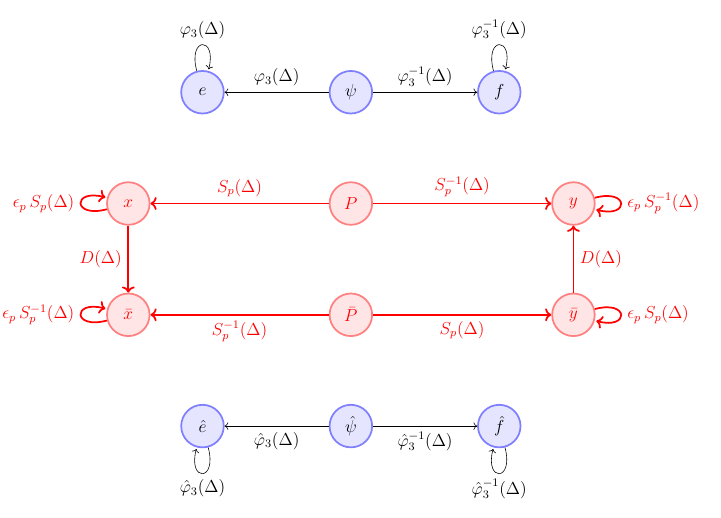
Figure 7 . OPEs between ( P ( z ) ; (cid:22) P ( z )) and the four single box generators f e ; f; ^ e; ^ f g .